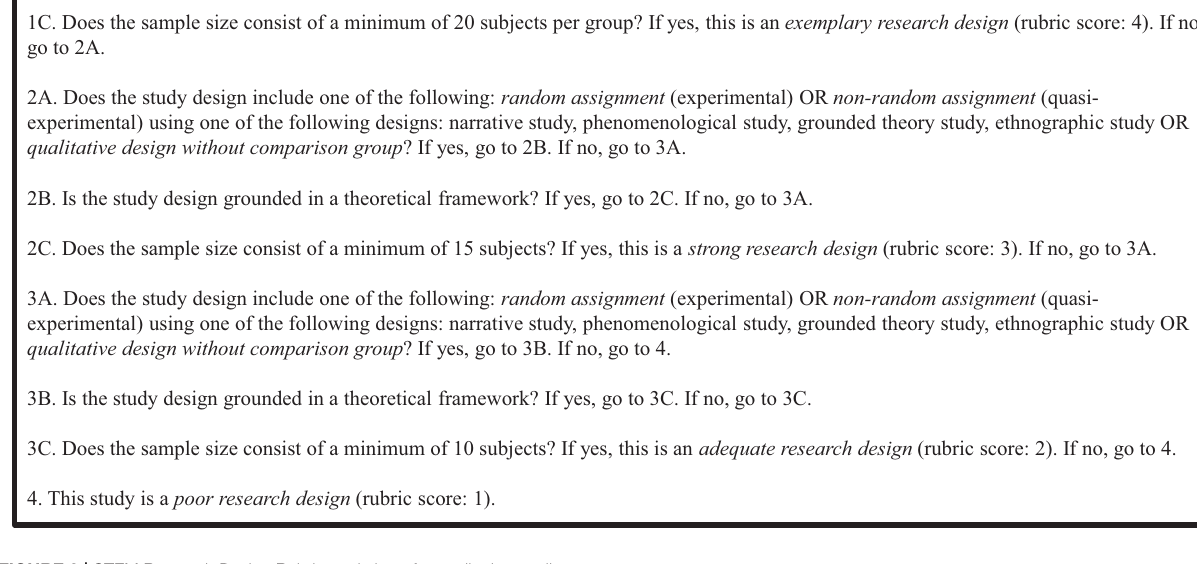
FIGURE 3 | STEM Research Design Rubric worksheet for qualitative